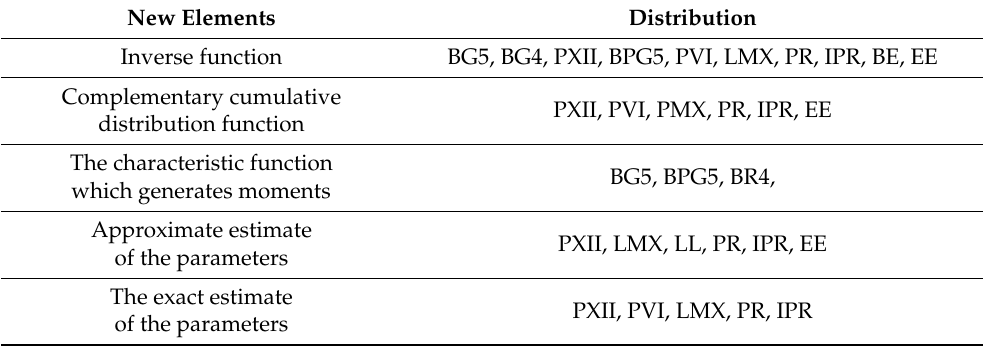
Table 1. Novelty